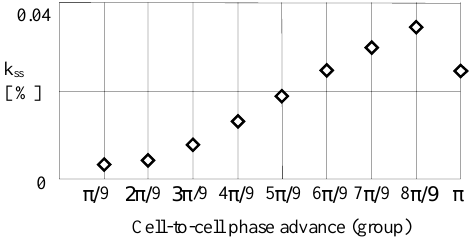
FIG. 2. An example of (cid:78) (cid:115) 7-cell cavities coupled by short interconnections (superstructure).